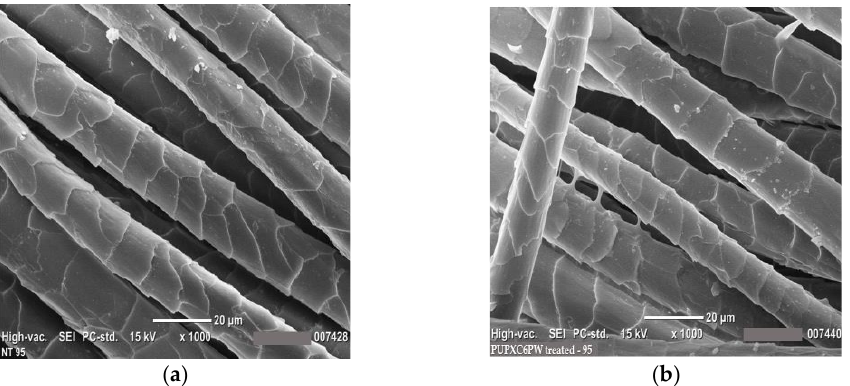
Figure 13. SEM images for untreated fabric ( a ) PUPXC6PW-treated fabric ( b ) and washed once at 95 °C.